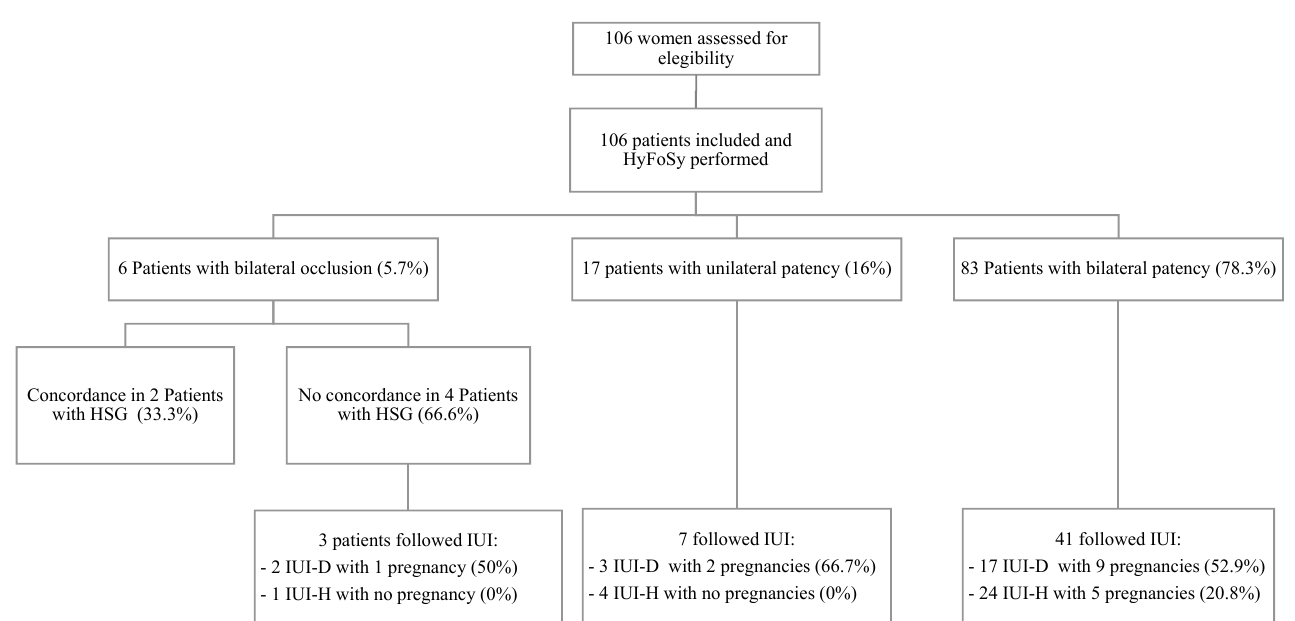
Figure 1. Flowchart of eligible participants. HyFoSy: hysterosalpingo-foam sonography; HSG: hysterosalpingography; IUI: intrauterine insemination; IUI-D: intrauterine insemination with donor semen; IUI-H: intrauterine insemination with husband or partner’s semen.